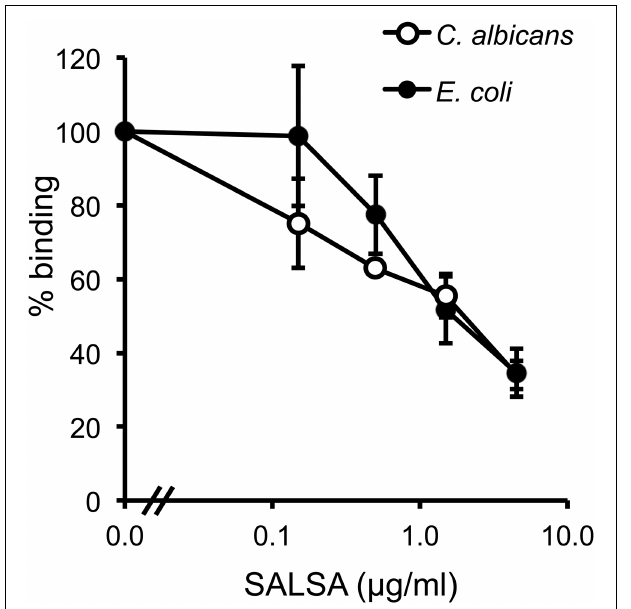
FIGURE 4 |The effect of fluid-phase SALSA on the binding of the MBL/MASP-2 complex to mannan. In an ELISA assay mannan was coated in microtiter wells. rMBL was mixed with rMASP-2 and varying amounts of rSALSA were added. Binding was detected with an anti-MBL antibody. A dose-dependent inhibition of MBL binding by rSALSA was observed. As a control, a similar analysis using an anti-MASP-2 antibody confirmed the inhibition.The results are expressed as percentage of MBL or MASP-2 binding in the absence of SALSA. Averages and SDs of three experiments performed in duplicate are shown.